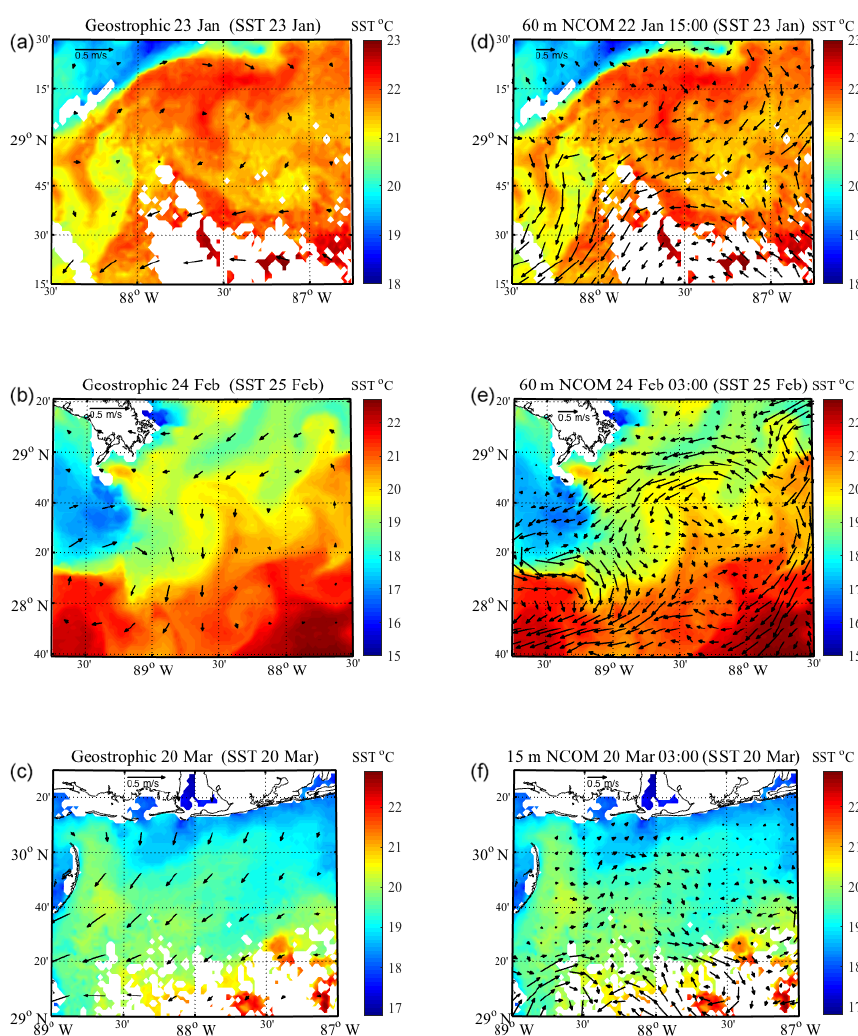
Figure 9. Aviso-based geostrophic velocities (a, b, c) and NCOM velocities (d, e, f) associated with each high wind event, along with relevant SST data. SST maps were chosen based on coinciding timing with each high wind event and/or visibility of circulation patterns. The date of each daily geostrophic velocity or 3h NCOM velocity field are listed for each panel. Dates of SST data are listed in the same manner as in Figs. 7 and 8. NCOM velocities are plotted at 60m depth for the January and February events, while they are plotted at 15m for the March event. Velocity arrows for geostrophic velocities are scaled twice as large as those of NCOM